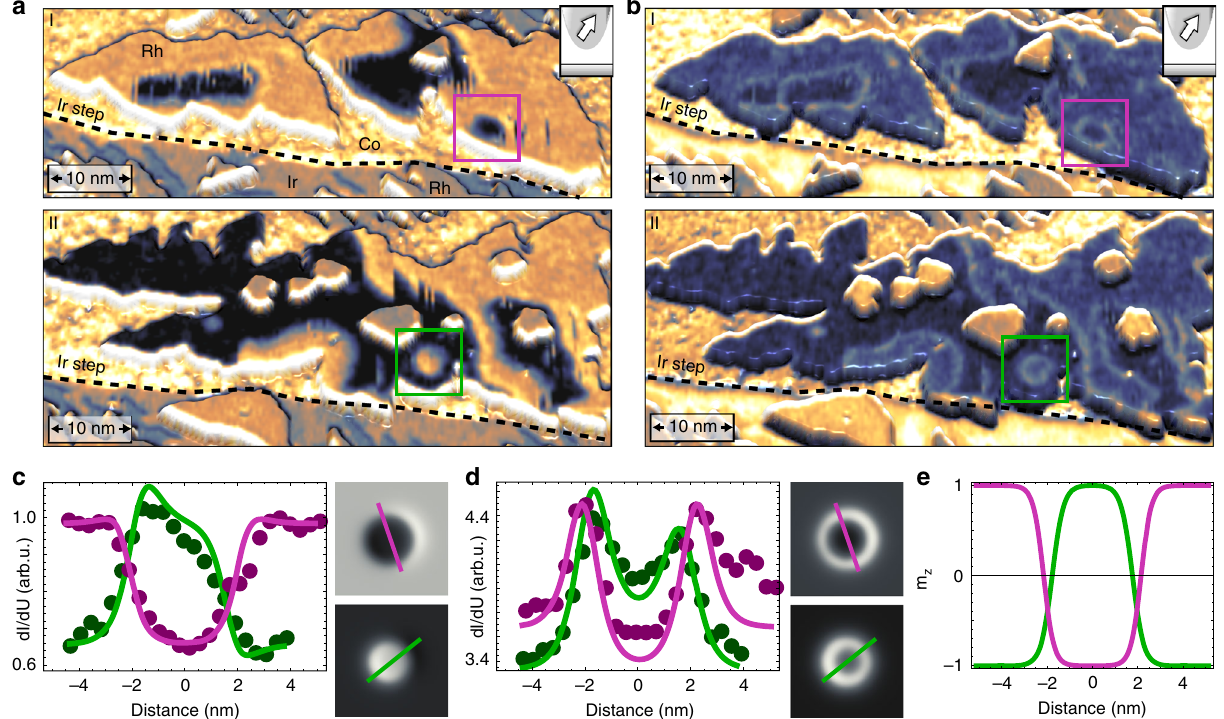
Fig. 2 Zero fi eld skyrmions in hcp-Rh/Co/Ir(111). a , b Perspective views of STM topography colourized with simultaneously measured spin-resolved dl/dU maps at different bias voltages; these are the sample areas indicated by the rectangles in Fig. 1. Whereas in a the TMR contribution dominates and the FM domains can be identi fi ed by their two-stage contrast, in b the NCMR contribution is strong and the DWs appear as bright lines. The magnetic tip is identical for these measurements and it is sensitive to both the out-of-plane and an in-plane component of the sample ’ s magnetization (see sketches in the insets). Isolated skyrmions with opposite magnetization are indicated by the boxes ( a U = − 250 mV; b U = − 400 mV; a , b I = 800 pA, B = 0 T, T = 4.2 K, Cr bulk tip, fast scan axis is vertical, color gradient as in Fig. 1). c , d dl/dU signal (dots) across the isolated skyrmions in a , b together with line pro fi les (solid lines) of STM simulations of two skyrmions (see Supplementary Note 1 and Supplementary Fig. 4). e Out-of-plane magnetization component m z across